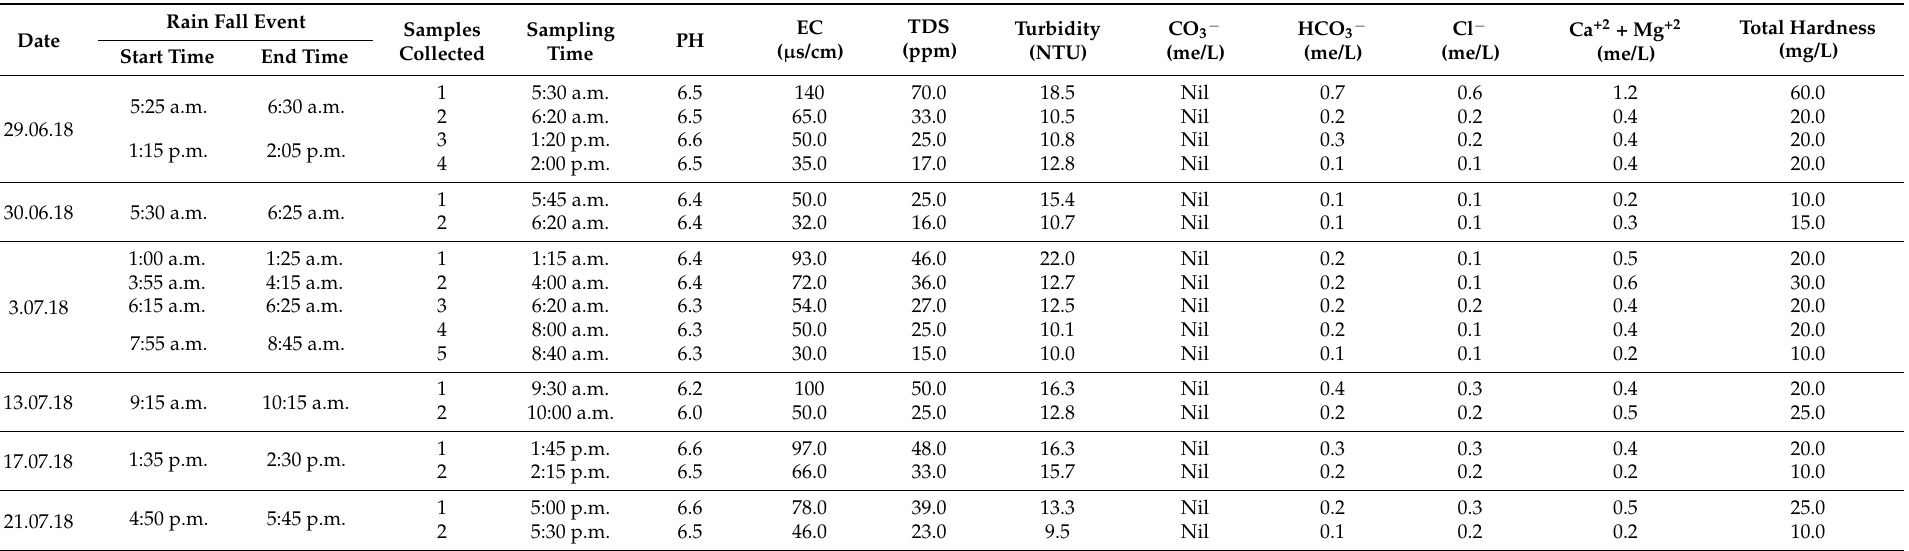
Table A9. Direct rain samples collected from Site